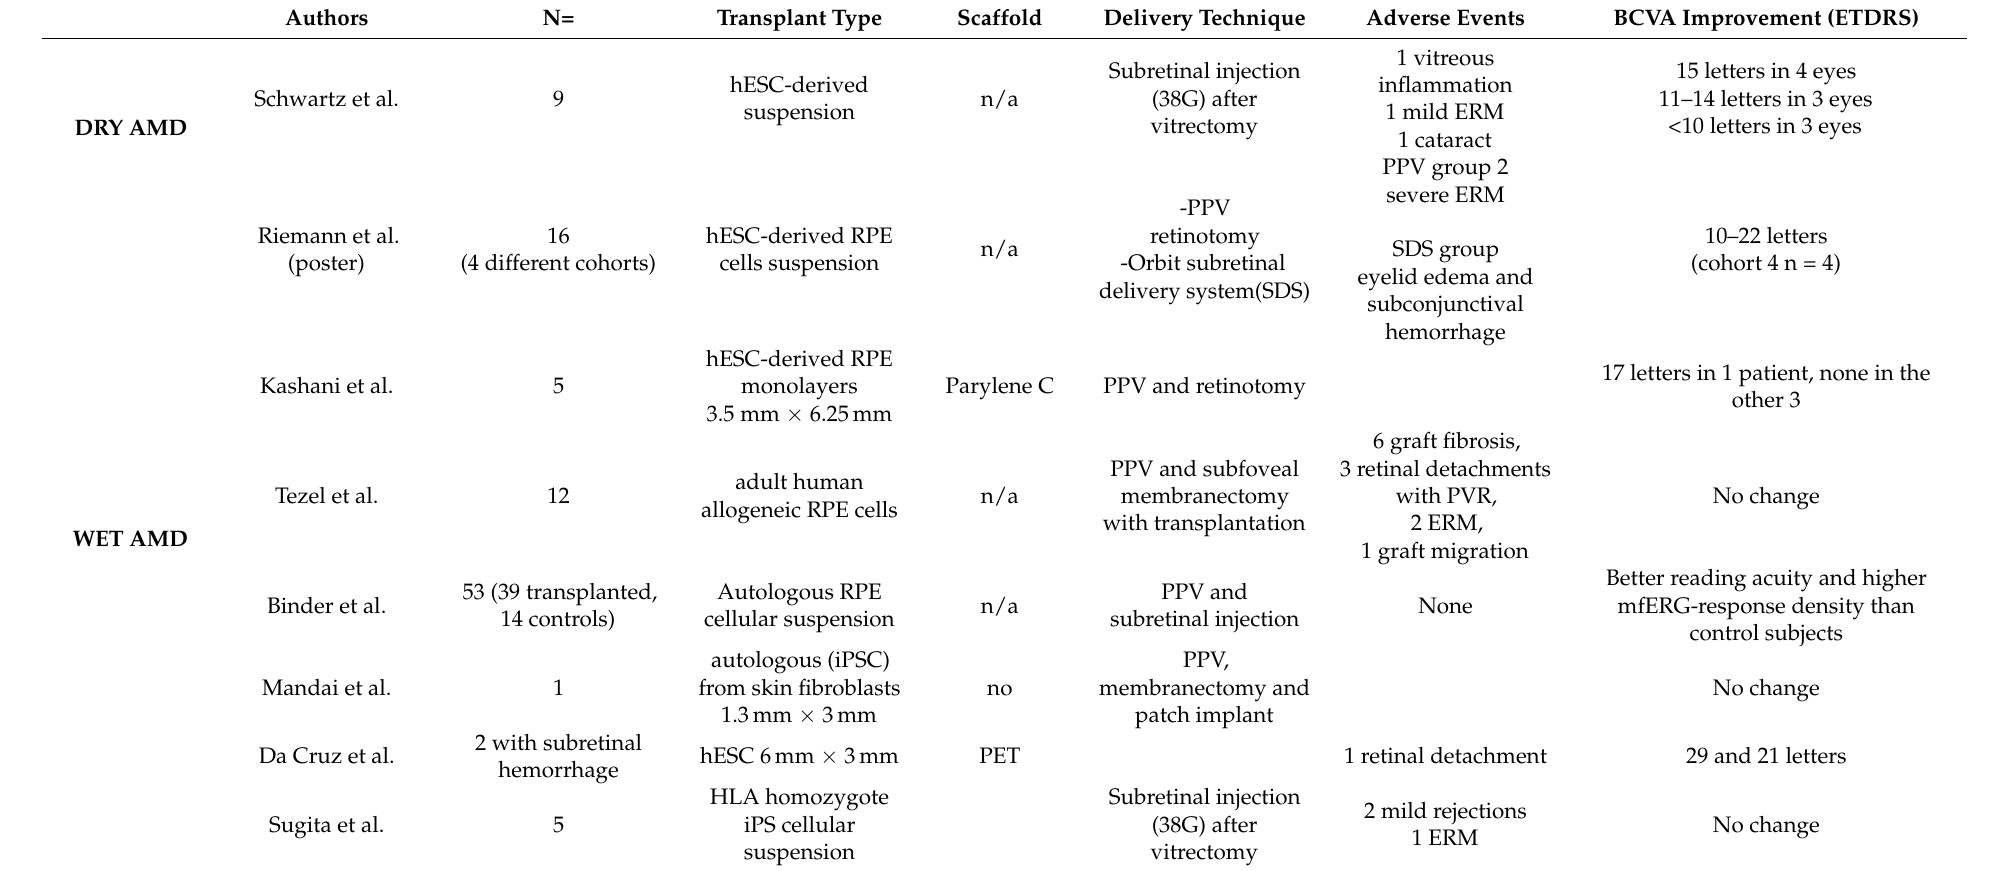
Table 1. Resume of published clinical